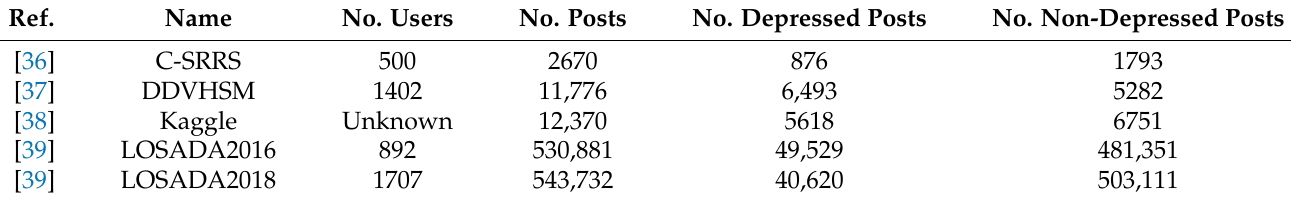
Table 4. Summary of